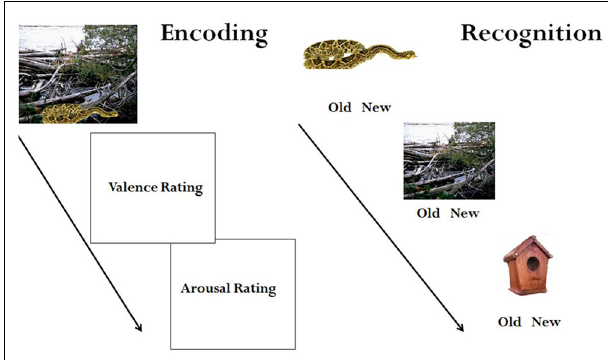
FIGURE 1 | Experimental design of Encoding and Recognition